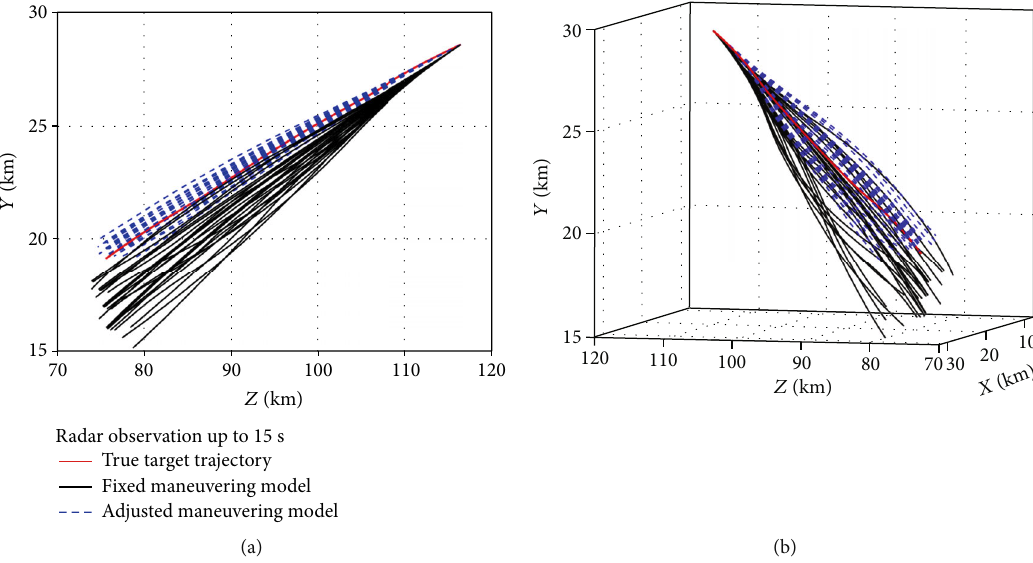
Figure 5: Comparison of the trajectory-prediction results between the proposed method and fi xed maneuver model. (a) Two-dimensional curve comparison. (b) Comparison of spatial